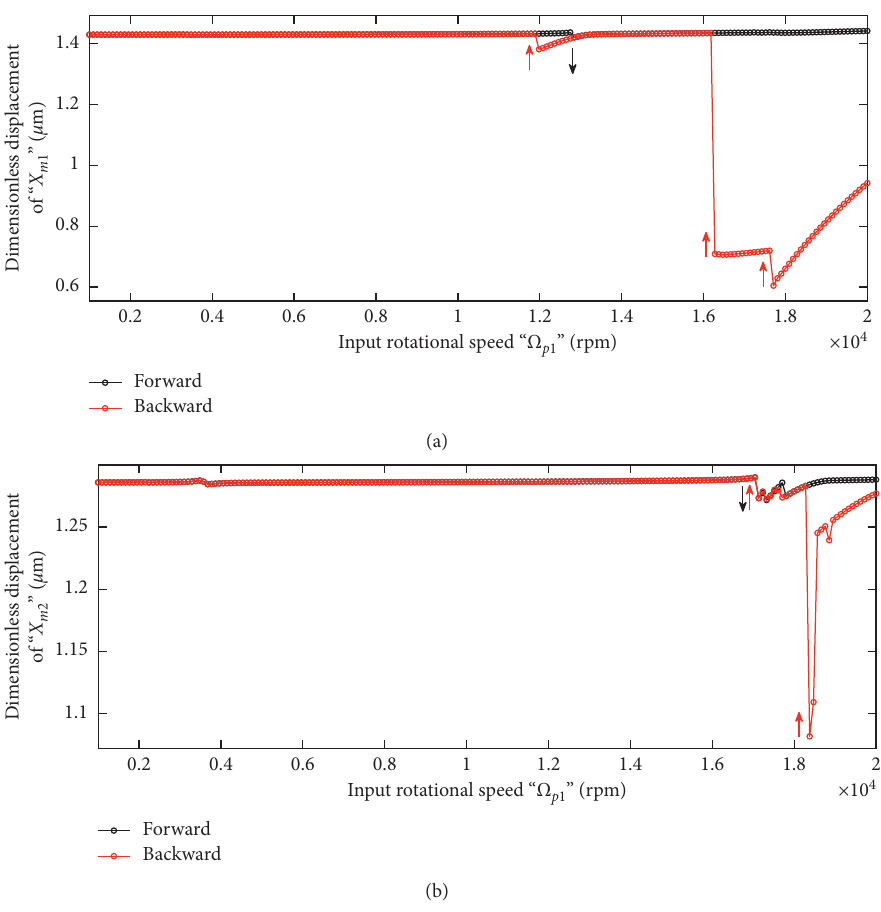
Figure 19: RMS curves of forward and backward bifurcation system; s